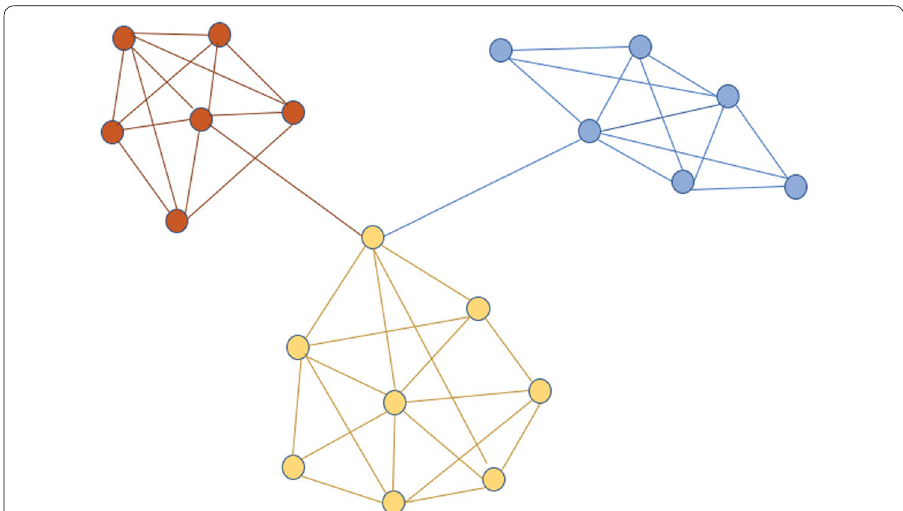
Fig. 1 A simple graph with communities highlighted by different colors. A graphical representation of a sample graph with